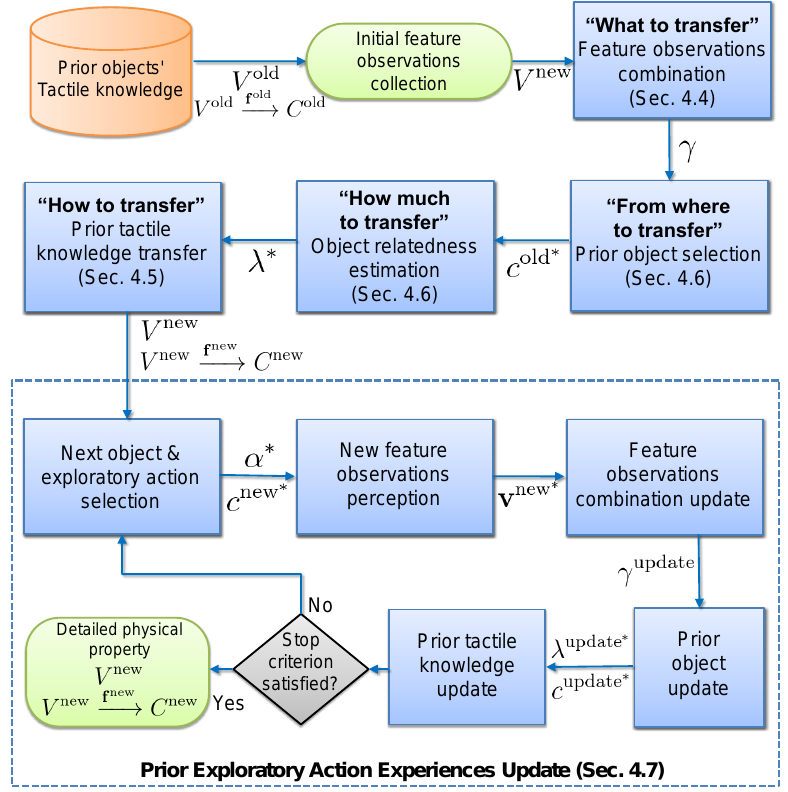
Figure 4. Flowchart of the Active Prior Tactile Knowledge Transfer